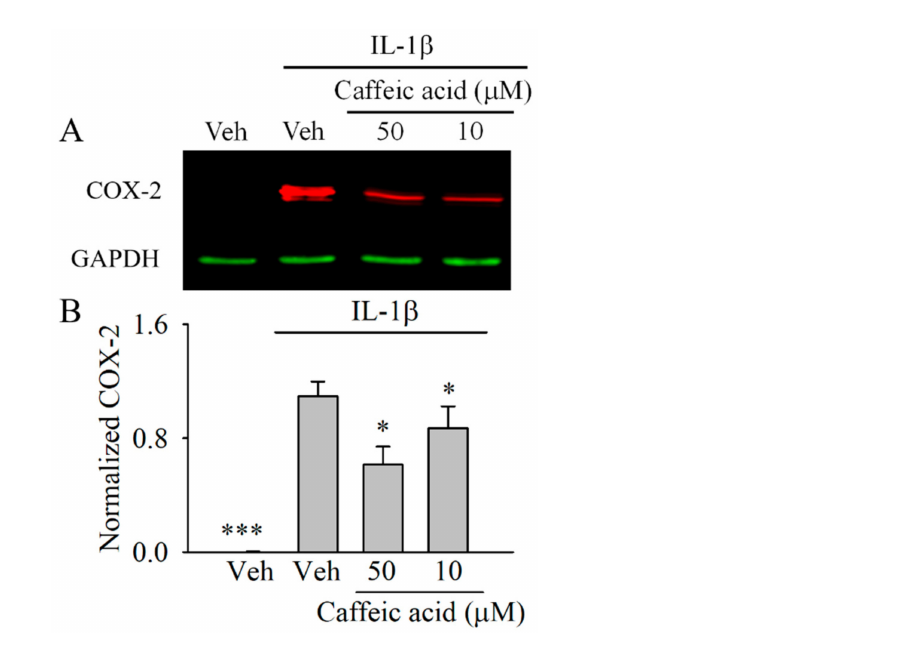
Figure 3. Dose-dependent effect of caffeic acid on cyclooxygenase 2 (COX-2) expression in interleukin 1 beta (IL-1 β )-treated myofibroblasts of the colon, CCD-18Co. Cells treated with DMSO (0.5% v / v ) were used as control. In the absence of caffeic acid, the cells were treated with 0.5% ( v / v ) DMSO in the presence or absence of IL-1 β (inflamed or control cells, respectively). The expression of COX-2 was normalized to Glyceraldehyde 3-phosphate dehydrogenase –GAPDH- (ratio COX-2/GAPDH) and shown as normalized COX-2. ( A ) Illustration of the effect of 50 and 10 µ M caffeic acid on the IL-1 β -induced COX-2 expression in the myofibroblasts of the colon, CCD-18Co. ( B ) The bar graph shows the data as the average ± standard deviation (SD) of three independent experiments ( n = 3). Significant differences are indicated in the figures as follows: * p < 0.05 and *** p < 0.001.